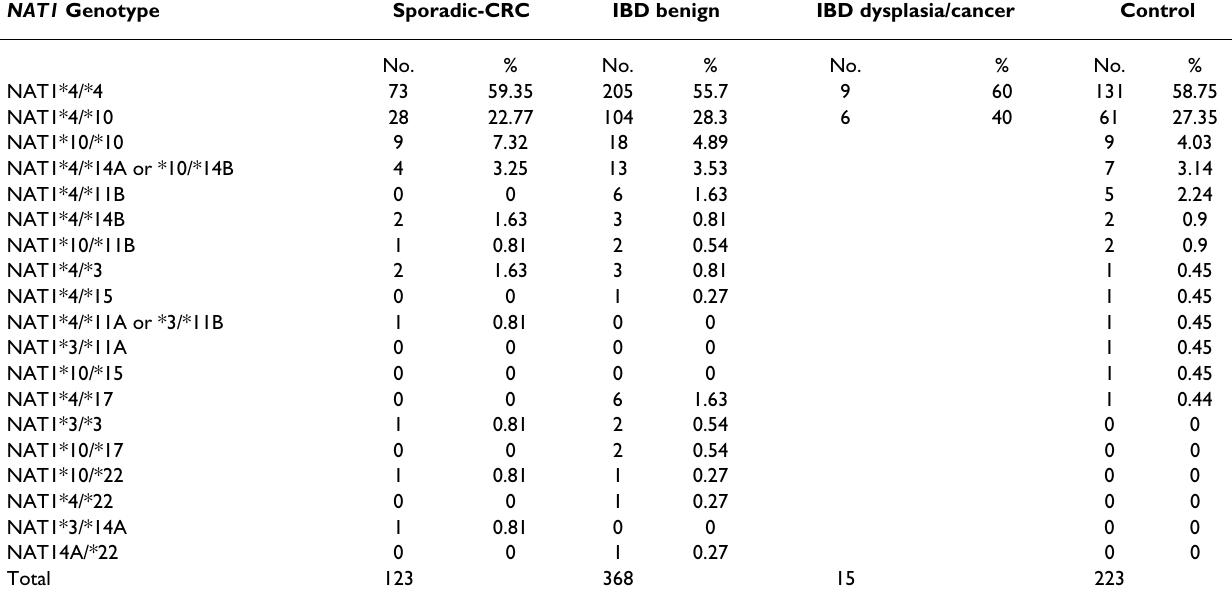
Table 2: NAT1 genotype frequency. NAT1 Genotype